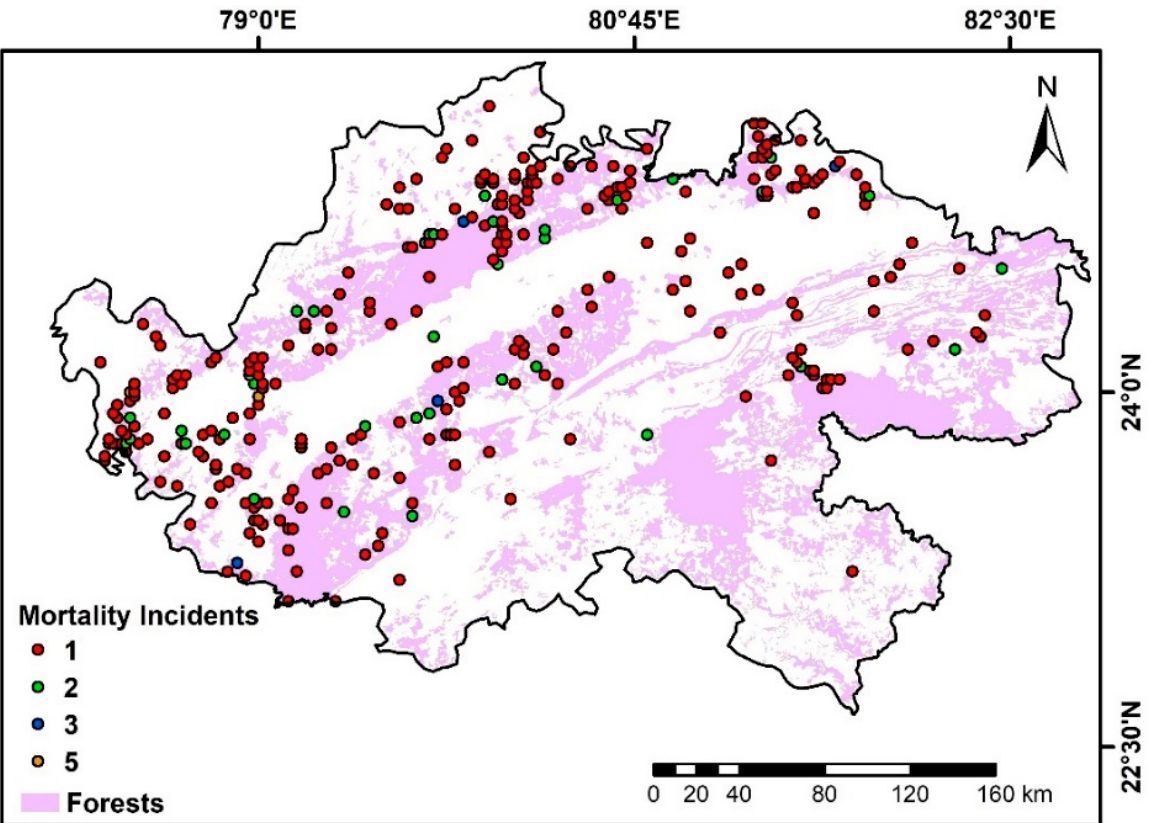
Figure 4. Antelope mortality location data used for modelling high-risk areas. Only the areas in Madhya Pradesh state have been modelled.